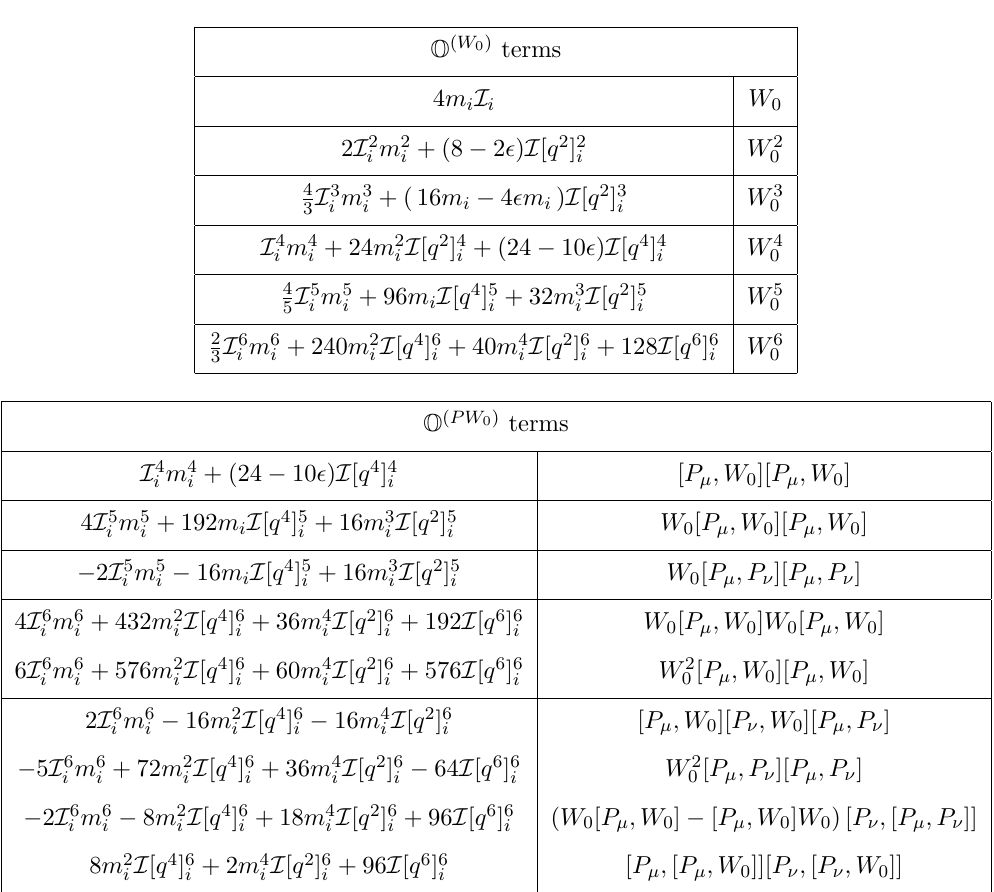
Table 5 . Operator structures in the degenerate fermionic UOLEA involving the scalar coupling W 0